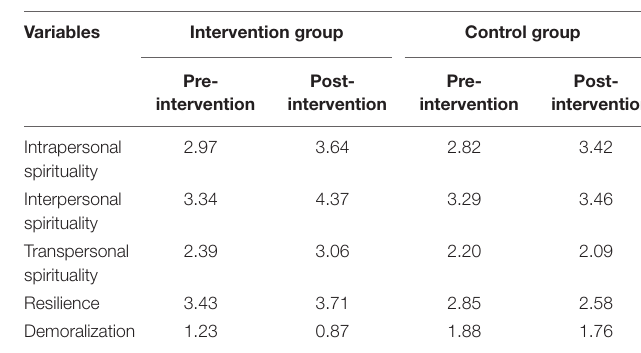
TABLE 4 | Pre- and post-intervention mean values for the intervention and control